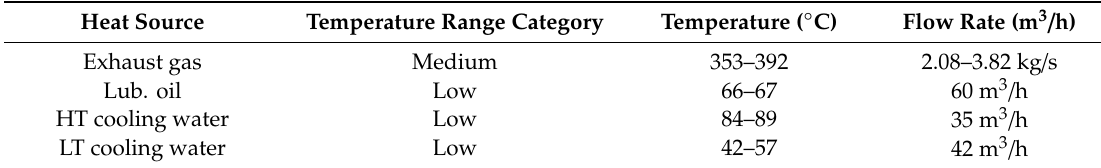
Table 5. Engine heat source and flow